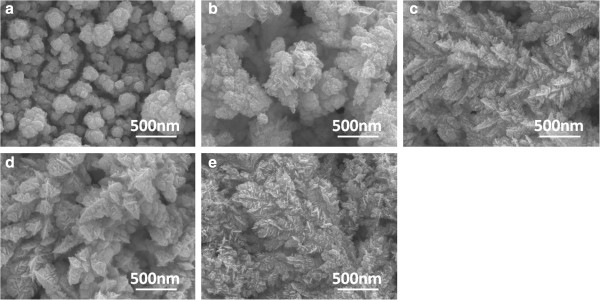
SEM micrographs of formula 0.015 M Bi(NO3)3-5H2O, 0.005 M SbCl3, and 0.0075 M TeCl4. SEM micrographs of the electrolyte formula 0.015 M Bi(NO3)3-5H2O, 0.005 M SbCl3, and 0.0075 M TeCl4, as a function of reduced voltage (a) -0.2 V, (b) -0.3 V, (c) -0.4 V, (d) -0.5 V, and (e) -0.6 V.